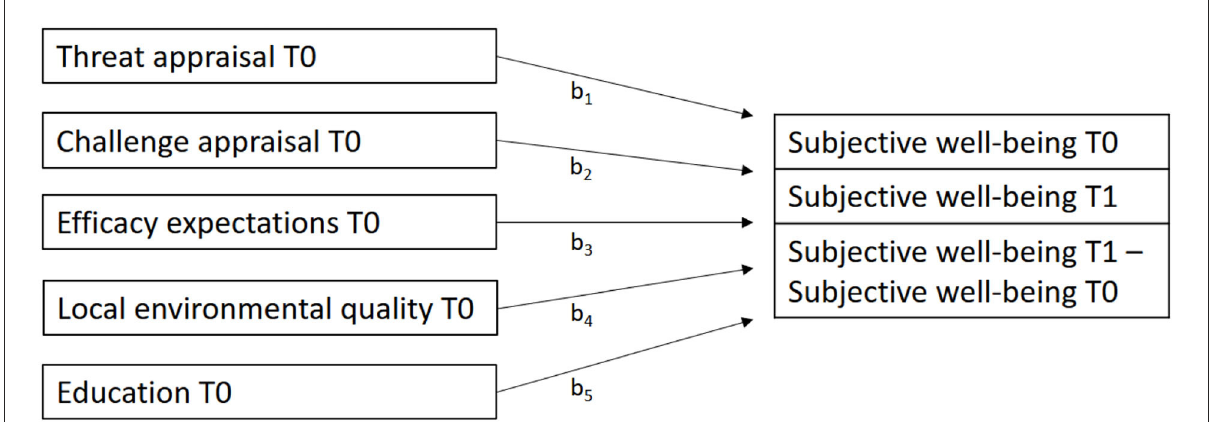
FIGURE1 Path diagram representation of the moderation model for the two-occasion within-subjects repeated measure design. Displayed is the model to explain both subjective wellbeing at T0 (June 2020) and T1 (June 2021) as well as the change in subjective wellbeing. b 1 to b 5 represent the effects of each variable, respectively, of each moderator on the respective outcome